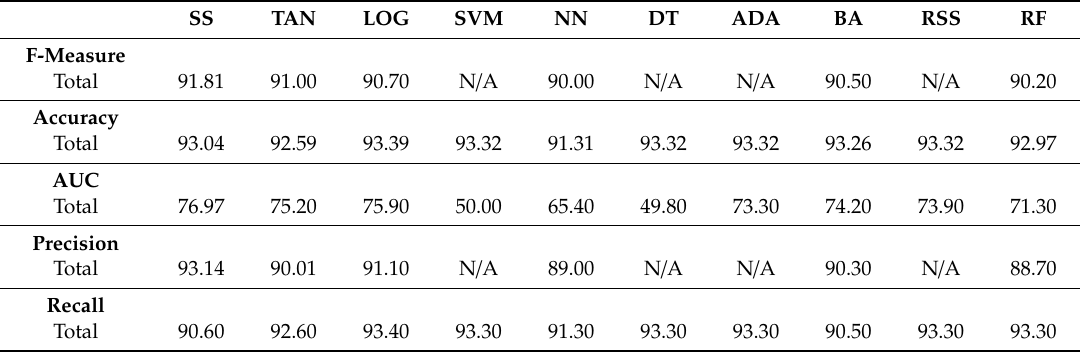
Table 2. Performance of the Sons and Spouses algorithm against common benchmark models.